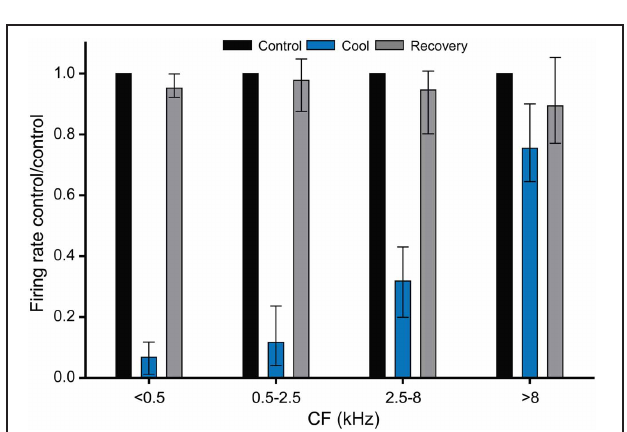
effect in the deepest position. (C) Ratio of firing rate in the cool and control conditions as a function of unit CF for single and multi-unit cluster recordings pooled across experiments. The reduction in firing with cooling was most evident for low CFs (dorsal locations), while neurons with higher CFs in more ventral locations were less affected. Regression line (black) and 95% confidence limits (blue).